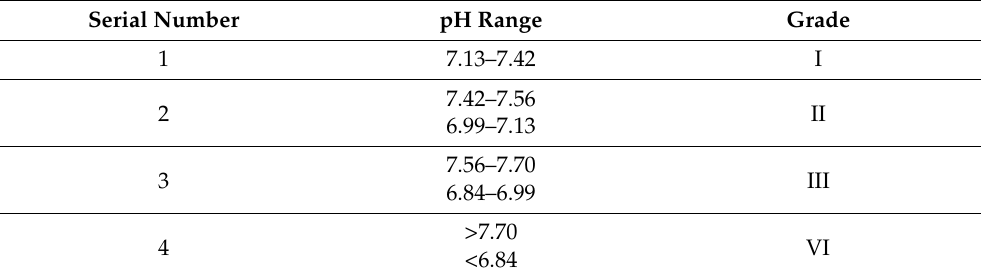
Table 2. The soil pH grade table.